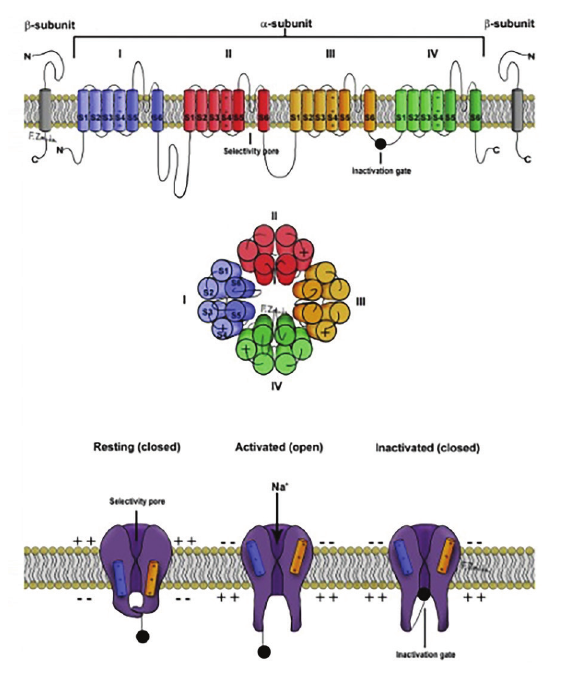
Figure 2 - Structure and configurations of the voltage gated Na+ channel. Reprinted from "Basic pharmacology of local anaesthetics" by A. Taylor and G. McLeod, 2020, BJA Education, 20(2), p.